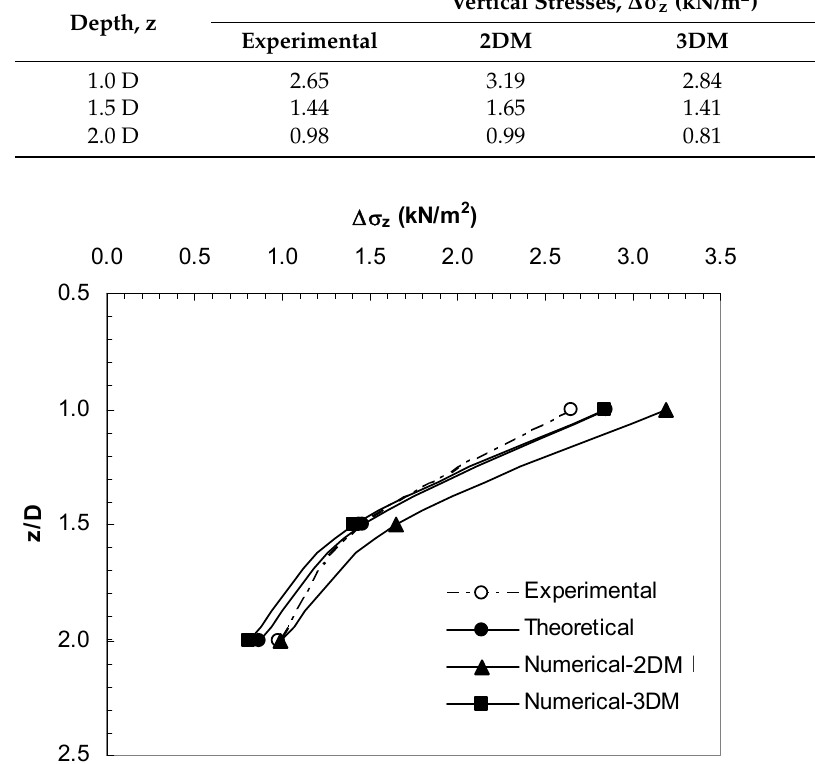
Table 3. Vertical stress values beneath the centerline of the 85 mm circular footing. Depth, z